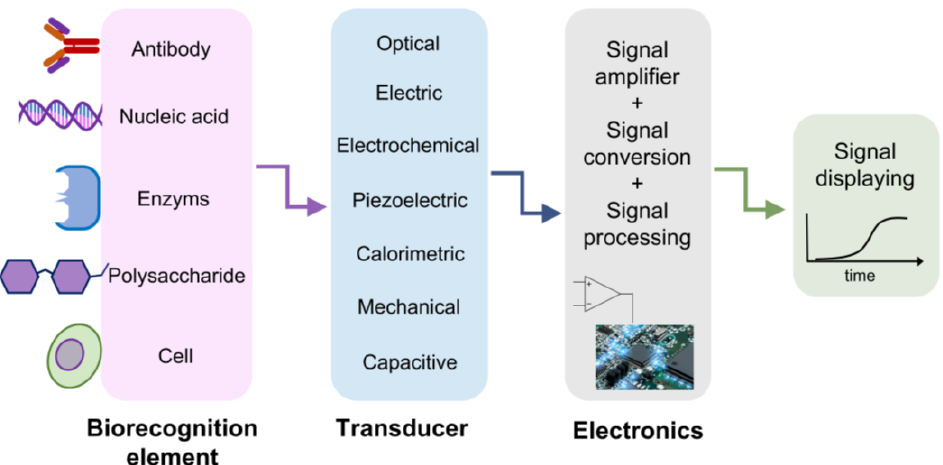
Figure 1. A schematic representation of biosensor structure. The biorecognition element is chosen to effectively catch the analyte of interest. The transducer reveals the presence of the analyte thanks to the variation of a physical quantity, depending on the approach exploited. The achieved signal is amplified, digitalized, processed and read on a display.